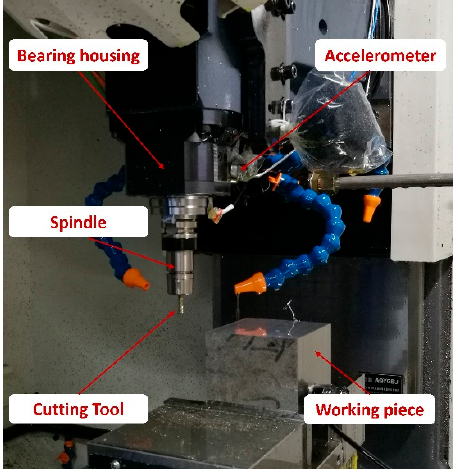
Figure 12. The CNC machining center test bed.